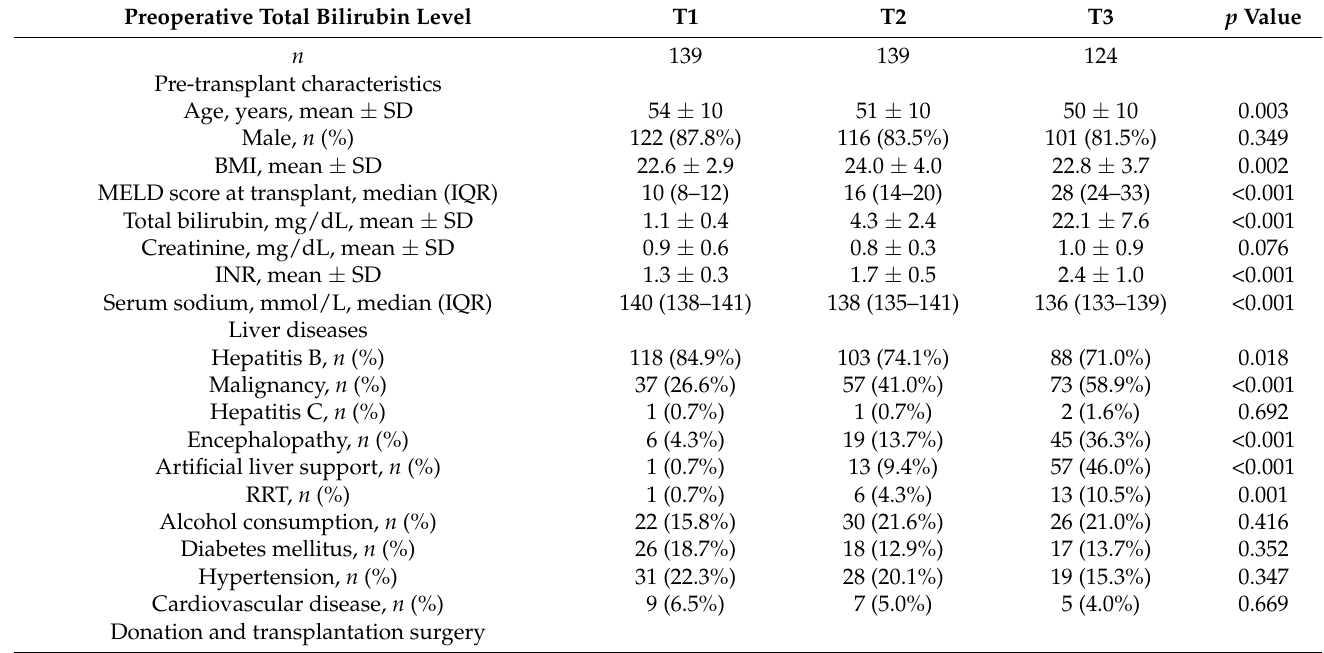
Table 1. Baseline characteristics of patients underwent liver